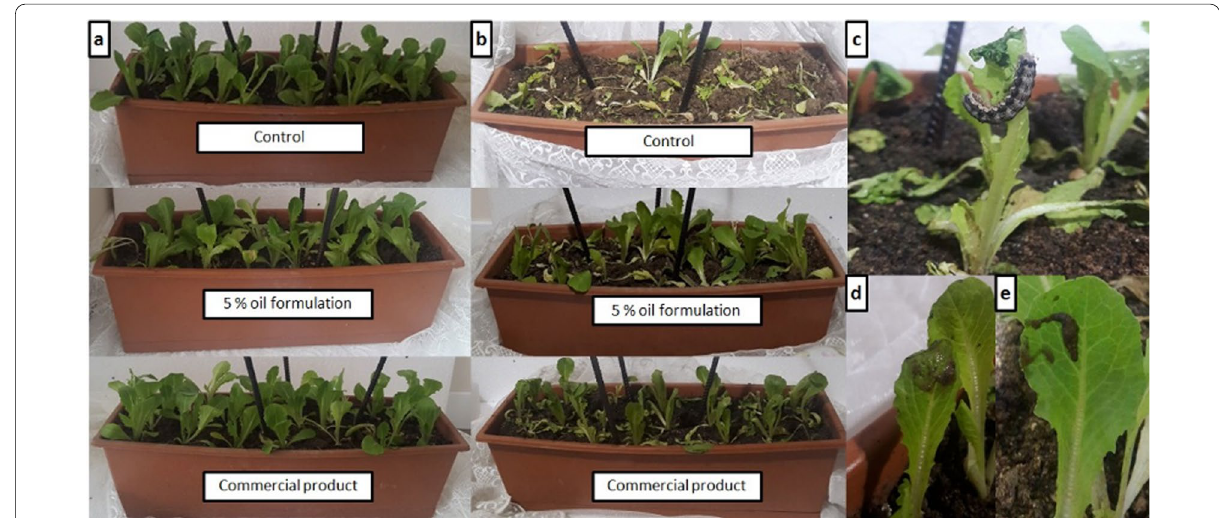
Fig. 4 Morphological effects of control group, 5% oil formulation and commercial product on 3rd instar Helicoverpa armigera larvae in lettuce seedlings. a Before application for all test groups, b after application, c Foliage consumption of H. armigera larvae on untreated lettuce seedlings, d , e . A cadaver of H. armigera larvae died after application of the d 5% oil formulation, and e commercial